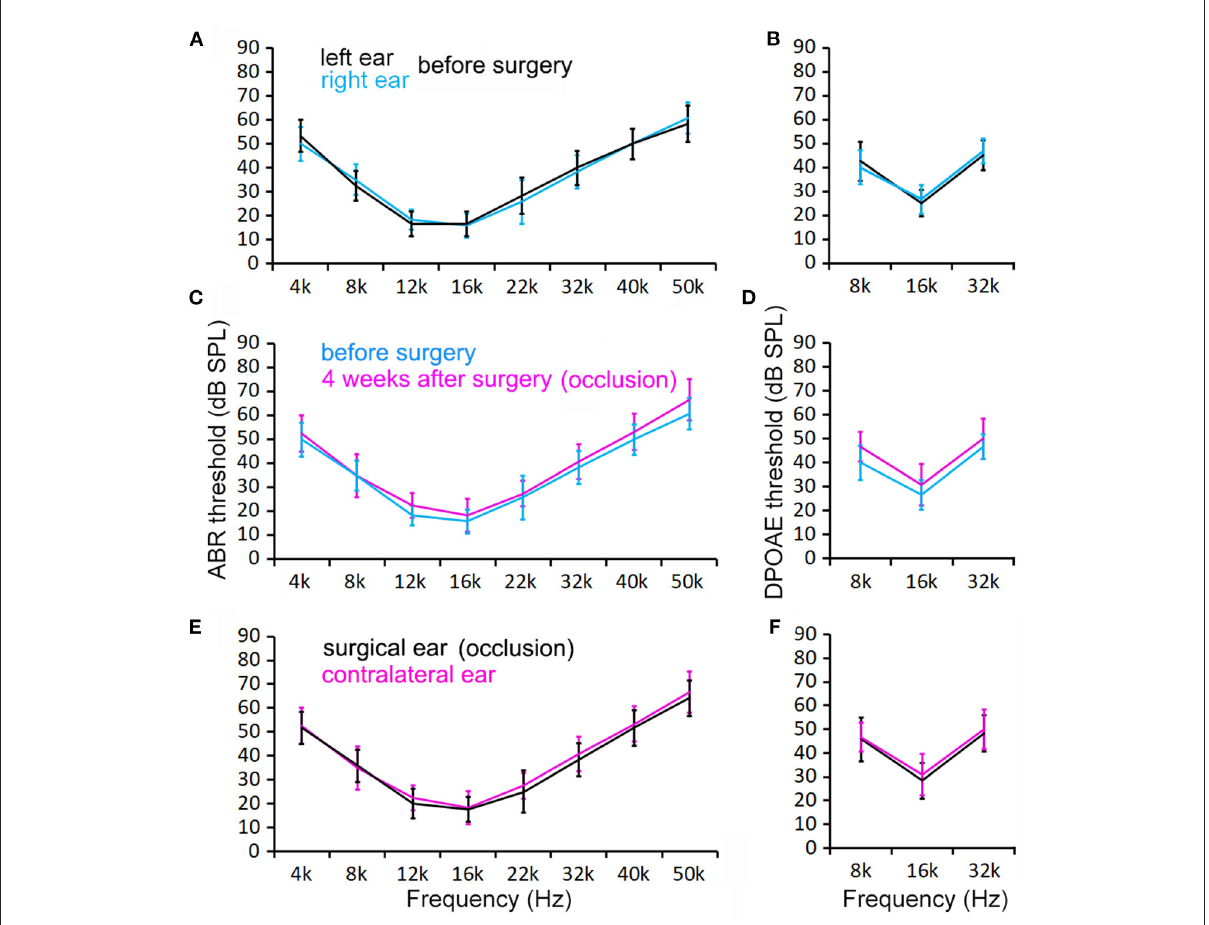
FIGURE4 ABR and DPOAE thresholds measured from control and surgical ears before and 4 weeks after surgery. (A,B) ABR and DPOAE thresholds of the right and left ears before surgery. No statistical significance in thresholds is found at any of these frequencies ( p > 0.05, n = 6). (C,D) ABR and DPOAE thresholds of the ears before and after occlusion. No statistical significance in thresholds is found at any of these frequencies ( p > 0.05, n = 6). (E,F) Control and surgical ears at 4 weeks after surgery. No statistical significance in thresholds is found at any of these frequencies ( p > 0.05, n = 6). Two-way ANOVA with multiple t- tests using the Holm–Sidak correction for multiple comparisons was also used to determine statistical